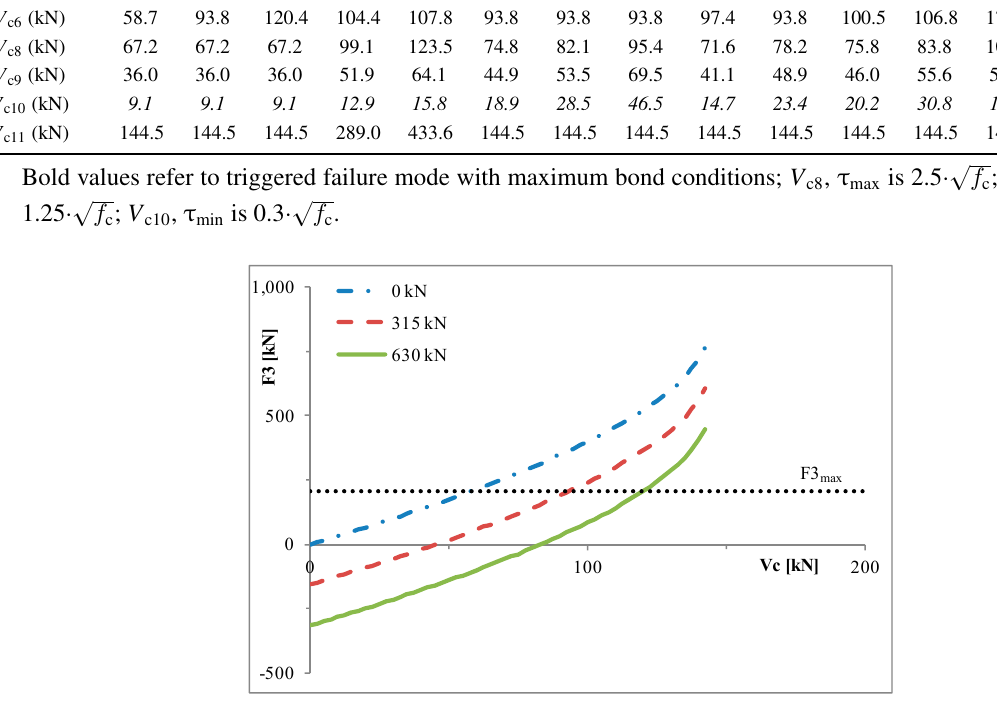
Figure 5. Parametric analysis: tensile force, F 3 , in column bars and its threshold with variability of axial load, N c .